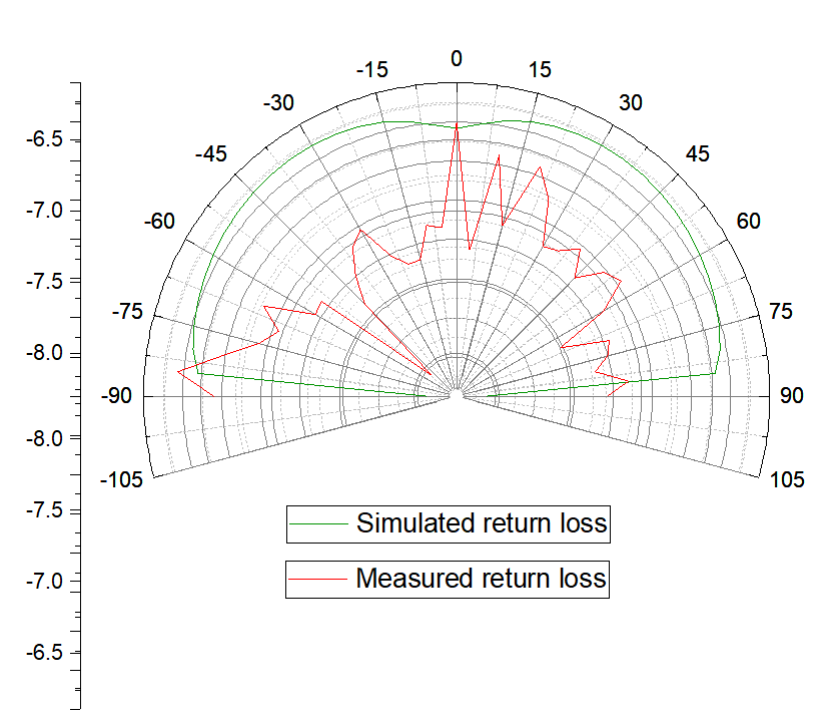
Figure 11. Simulated (green), fabricated (red)